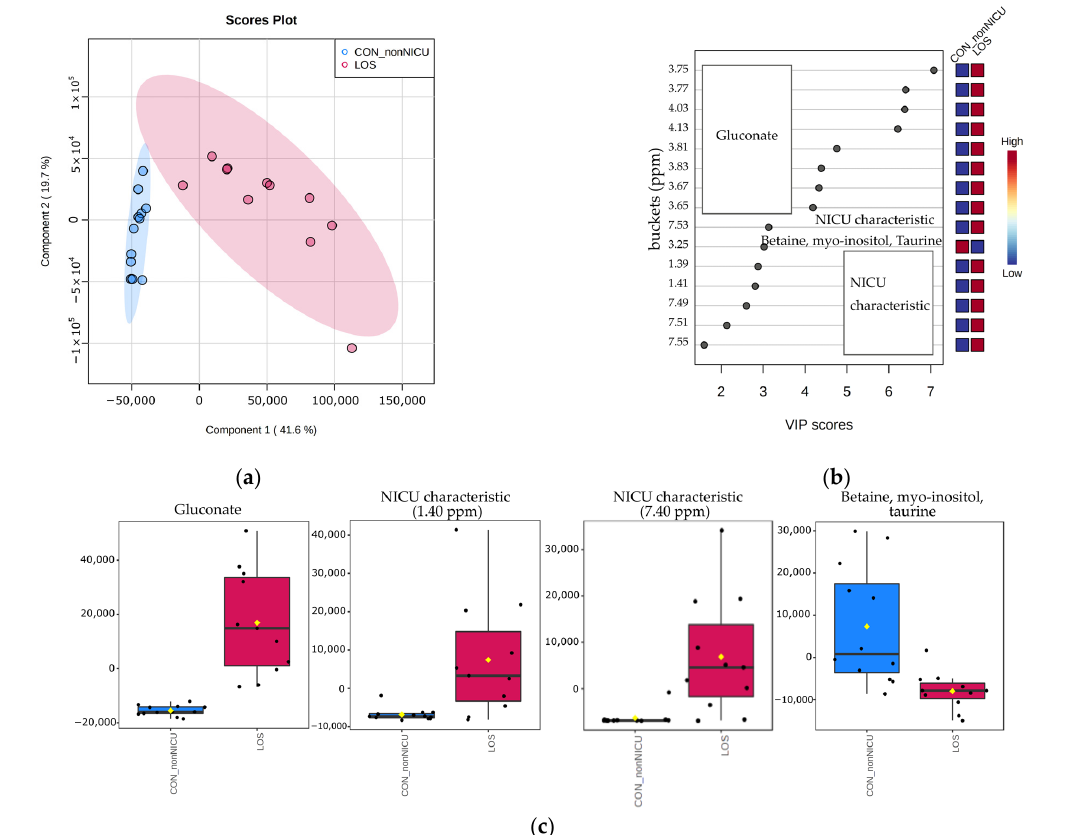
Figure 5. Multivariate analysis of NMR data belonging to neonates diagnosed with LOS (pink cir- cles) and control neonates without need for hospitalization (blue circles). ( a ) PLS-DA scores plot of the LOS and healthy non-NICU preterms without need for hospitalization. ( b ) VIP scores and me- tabolites related to buckets with different concentration among the two groups. ( c ) Box plots of nor- malized concentration for the discriminant metabolites.